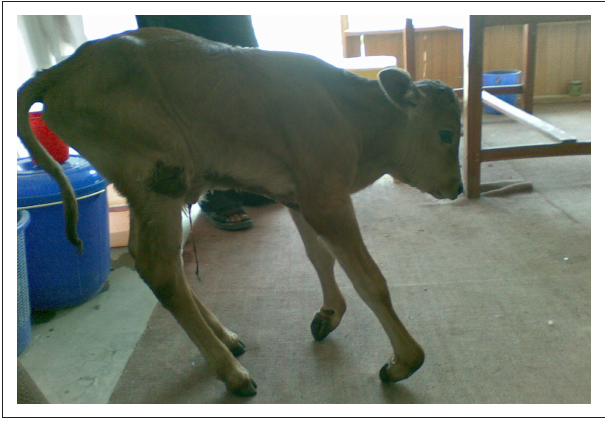
FIGURE 1: Photograph of a neonatal calf with moderate fetlock knuckling of the forelimb.